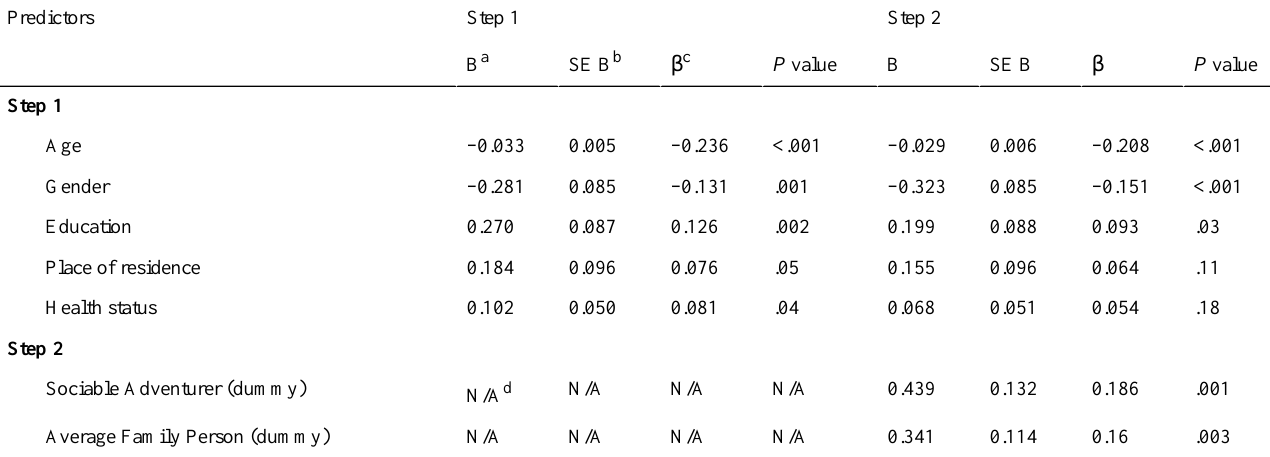
Table 4. Summary of hierarchical multiple regression analysis for variables predicting older adults’online health information–seeking behavior